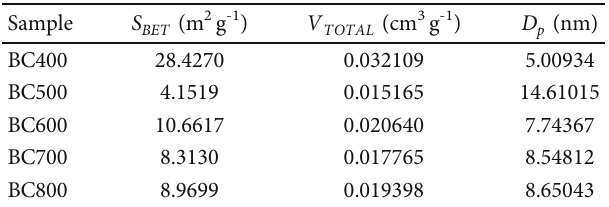
Table 2: E ff ect of temperature on the speci fi c surface area of